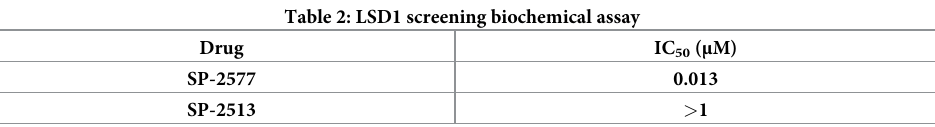
Table 2. Inhibition of LSD1 enzymatic activity of SP-2577 and SP-2513 measured by Resorufin assay in a cell-free system. Table 2: LSD1 screening biochemical